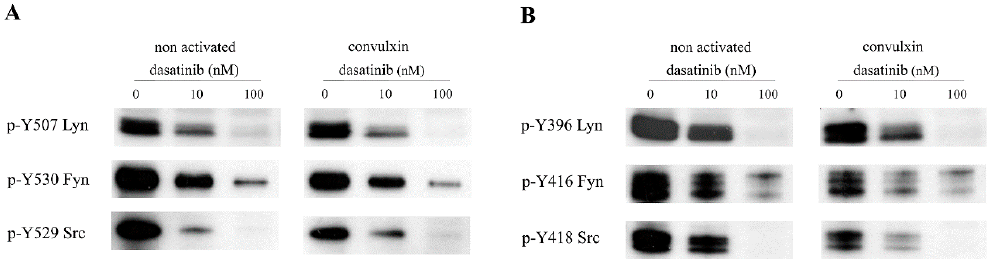
Figure 7. Phosphorylation status of SFK after dasatinib treatment upon convulxin activation. Gel filtrated human platelets from a healthy donor were incubated with 10 or 100 nM dasatinib or vehicle (0.2% DMSO) for 10 min. After incubation, platelets were left non activated or were activated with 12.5 ng/mL convulxin for 15 min. Platelet lysates were immunoblotted with phosphospecific antibodies against the inhibitory ( A ) and the full activatory ( B ) phosphorylation of Lyn, Fyn, and Src kinases.